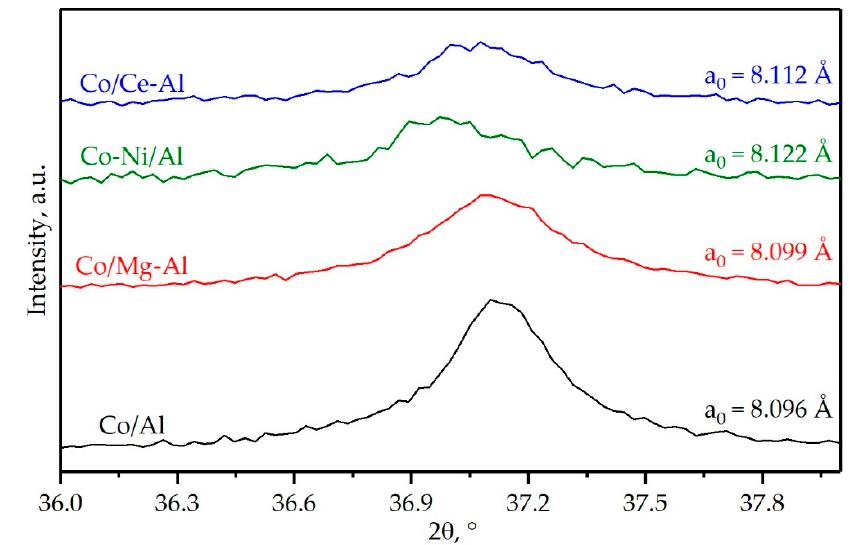
Figure 4. Close up view of the XRD patterns of the supported cobalt catalysts in the 2 θ = 36–38° range.